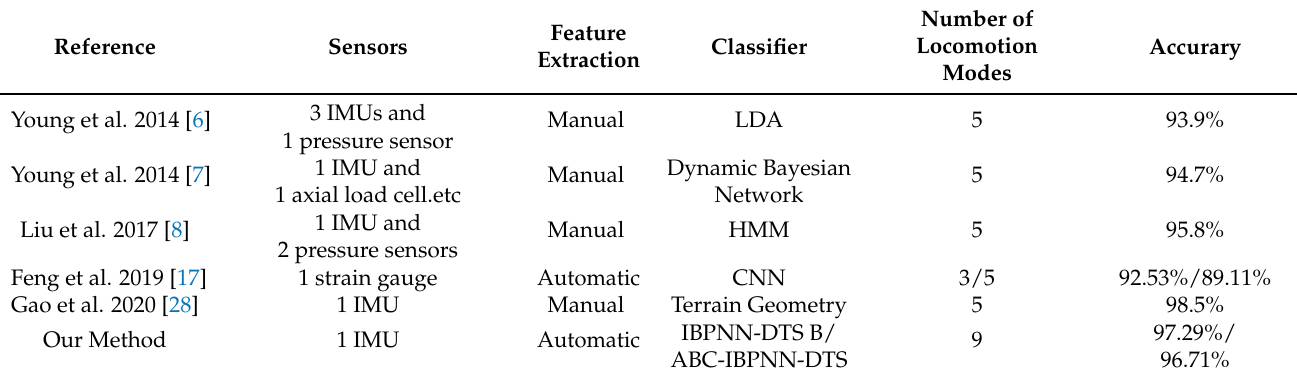
Table 3. Comparison with state-of-the-art